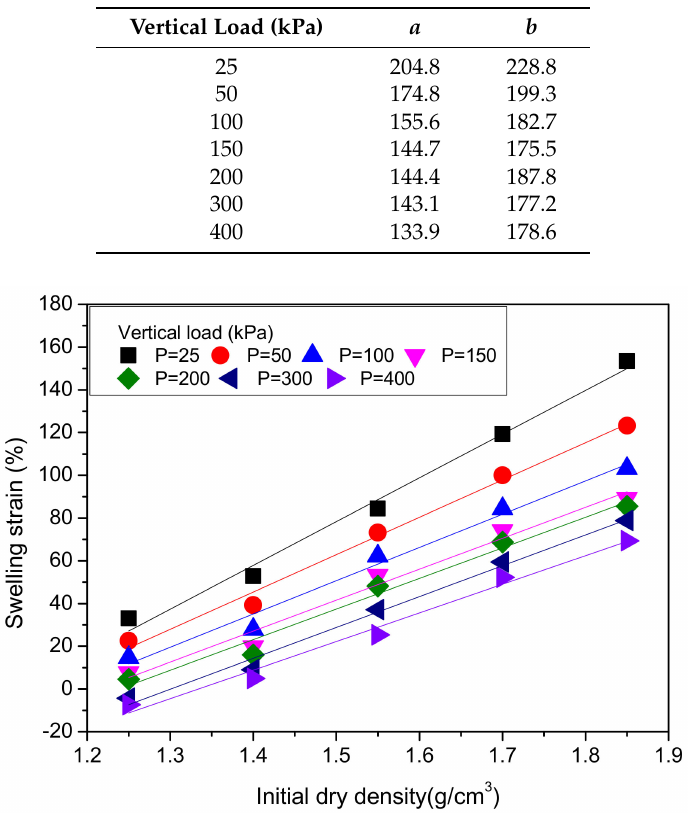
Table 5. Parameters relating to the relationship between swelling strain and initial dry density.